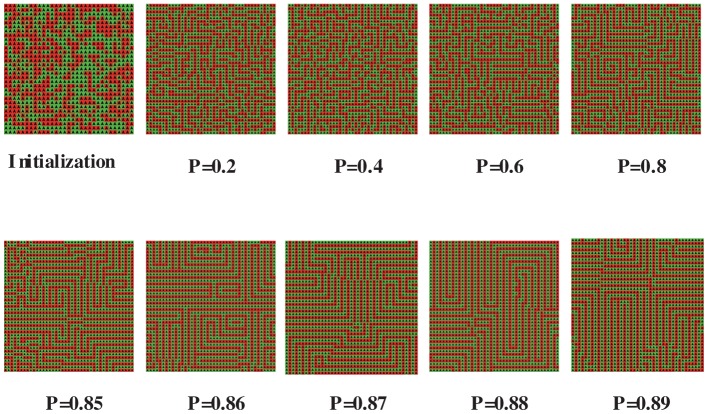
Emergence of mazes.r = 1, size = 4141.